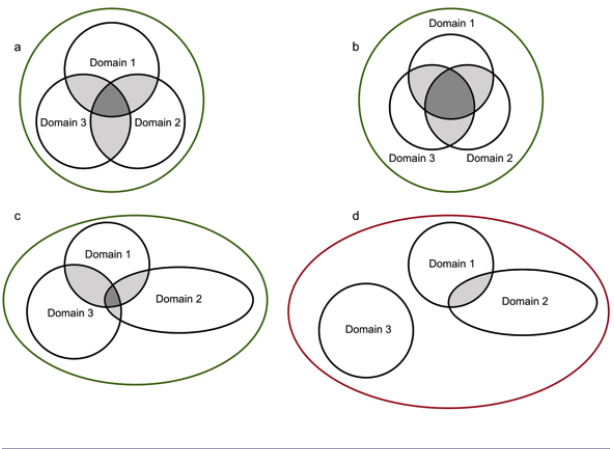
Fig. 1 . Schematic representation of the model. The external circle represents the livelihood system, which comprises three domains: environmental, social, and economic resources (not named in the figure to indicate that the change is not dependent on the domain). Whenever the three domains overlap, the system can be considered resilient (a, b, and c - green circle). The degree of resilience depends on the size of the overlapping areas: the more the three domains overlap (bigger area) the more resilient the system is. When one or more of the domains do not overlap with the others, the system is not resilient and the transition to a new system takes place (d - red